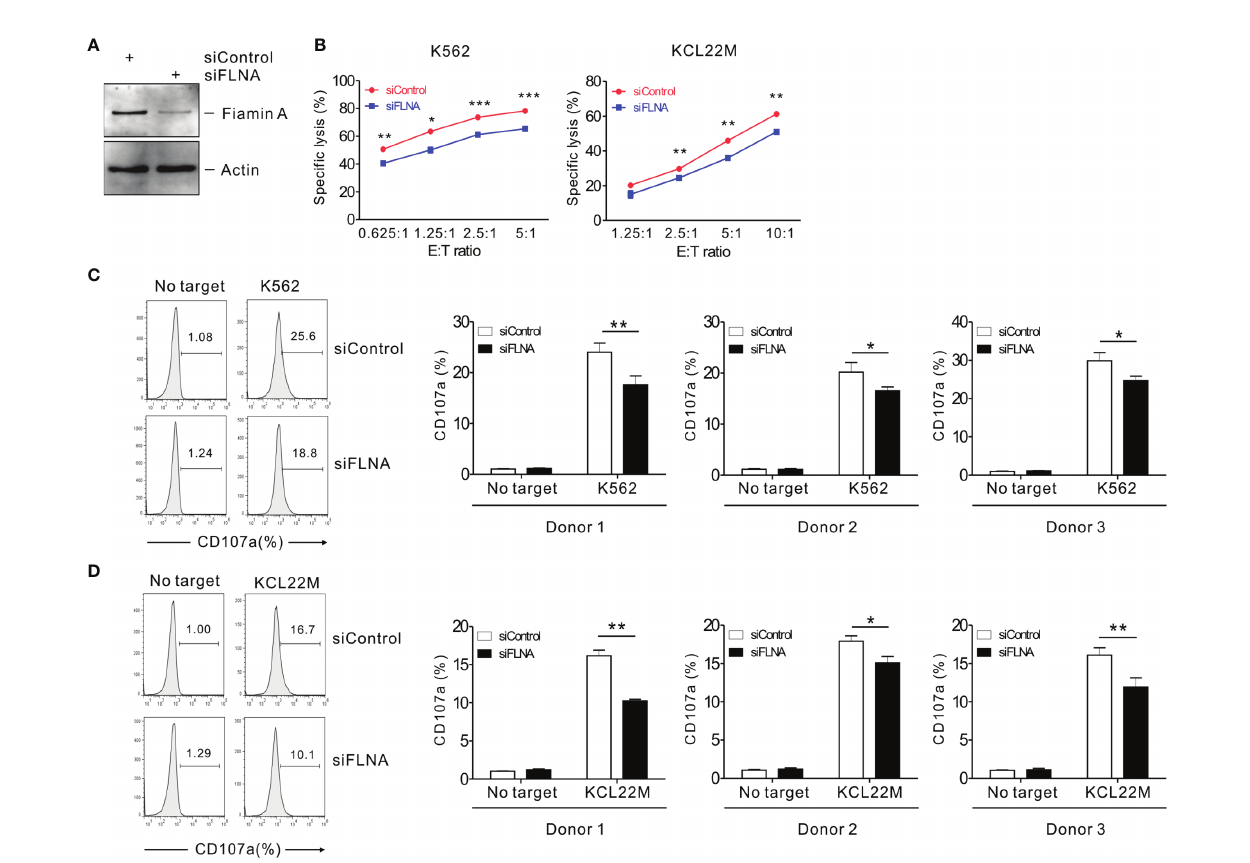
FIGURE 3 | FLNa regulates the cytotoxicity of primary NK cells. (A) Lysates of primary expanded NK cells nucleofected with control or FLNa-speci fi c siRNAs were assessed by immunoblotting for FLNa and actin. (B) Lysis of K562 cells or KCL22M cells by primary expanded NK cells nucleofected with control or FLNa-speci fi c siRNAs at the indicated E:T ratio. Cytotoxicity against K562 or KCL22M cells was determined using 1 h-europium release assay. (C, D) Primary expanded NK cells nucleofected with control or FLNa-speci fi c siRNAs were incubated with K562 (C) or KCL22M cells (D) with labeled anti-CD107a for 2 h degranulation assay. Then, the cells were surface-stained with labeled anti-CD56 mAb. CD107a expression by primary expanded NK cells was determined on CD56+ cells by fl ow cytometry. Representative FACS pro fi les ( left ) and summary graphs ( right ) indicating the expression of CD107a on primary expanded NK cells from three different healthy donors are shown. Error bars represent the SD; * P < 0.05, ** P < 0.01, *** P < 0.001. Data are representative of three independent